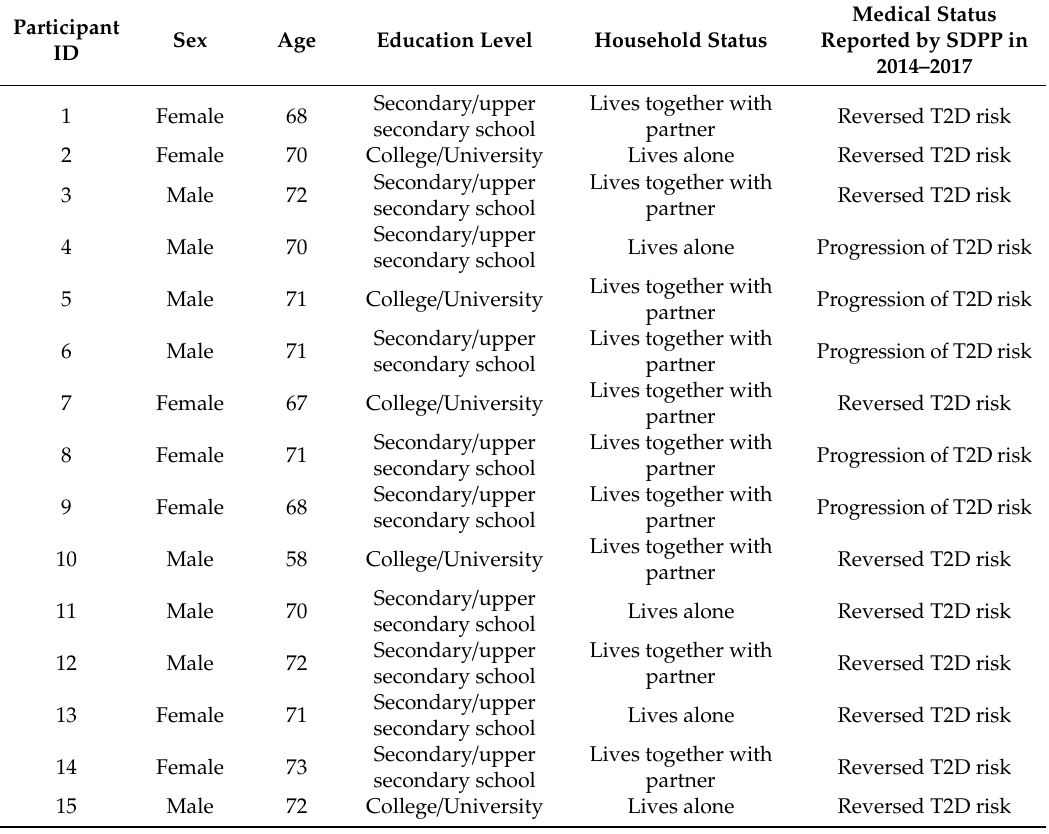
Table 1. Characteristics of 15 interview participants with high glucose values (prediabetes) between years 2004–2005 and